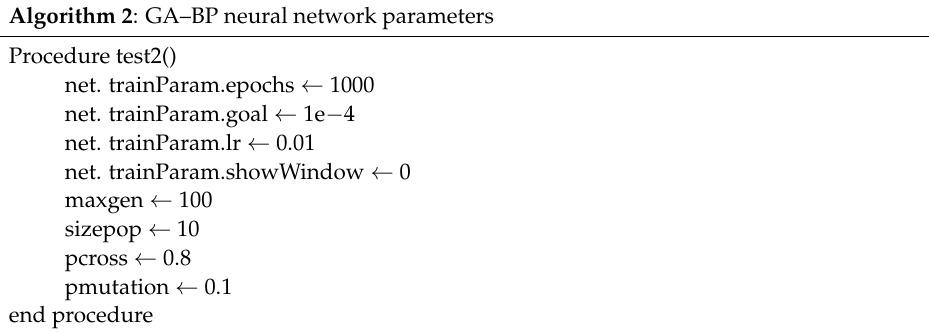
Figure 10. Actual value and predict value in train set. Figure 11. Actual value and predicted value in test set.